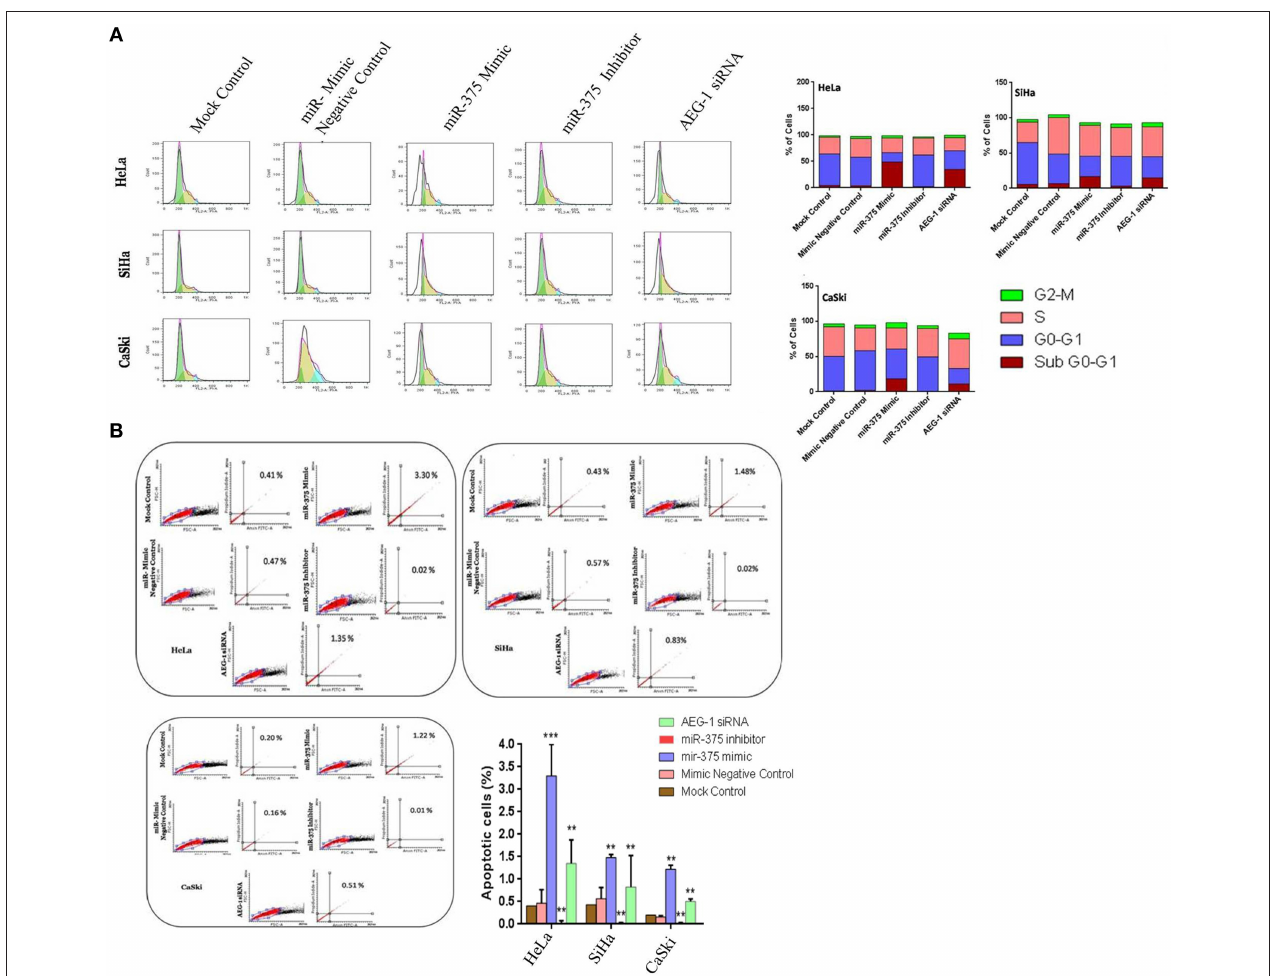
FIGURE 6 | miR-375 induces cell cycle arrest and apoptosis in vitro . CC cells were transfected with miR-375 mimic, miR-375 Inhibitor, AEG-1 siRNA, and their controls and 48h later, the effect of miR-375 on cell cycle was evaluated by the Flow cytometry (A) . Apoptosis was assessed in cells transfected with miR-375 mimic, miR-375 Inhibitor, AEG-1 siRNA, and their controls by Flow cytometry (B) . Error bars represent mean ± s.d. and P- values are represented as ** P < 0.05, *** P < 0.001 compared to the corresponding